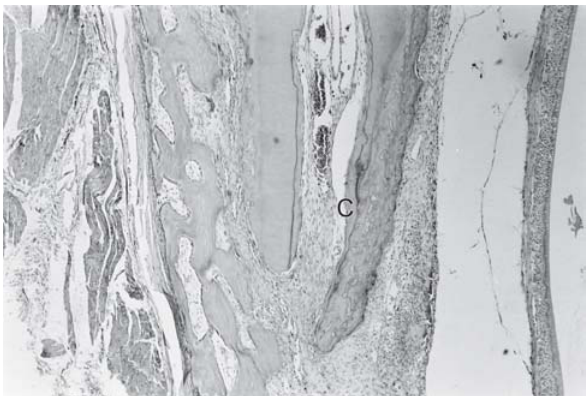
FIGURE 6 - Sealer 26. Note great resorption of the apical third of the root and only little resorption of the filling material (arrow). H.E. X 40